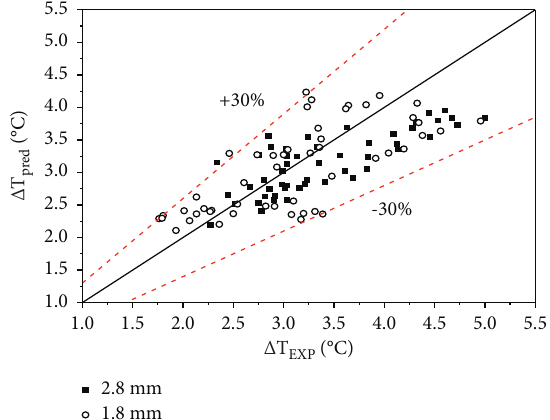
Figure 15: Comparison between experimental data and predicted values got by Thom’s correlation.